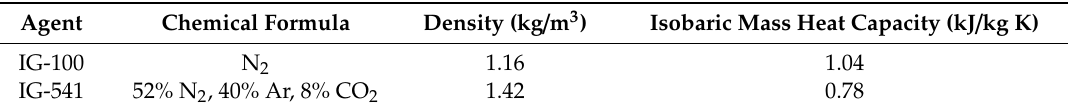
Table 1. Chemical and physical properties of inert gas agents at 1 atm and T = 293 K [2,14]. The fraction represents volume%.